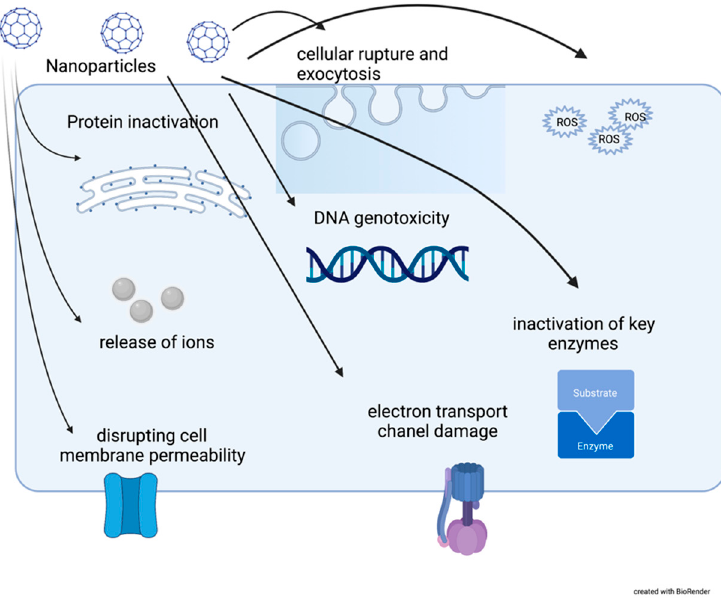
Figure 2. Nanoparticles’ mode of action on bacterial cells. Table 1. Baseline characteristics of chosen nanoparticles and nanomaterials, that are described further in the article. Nanoparticles/